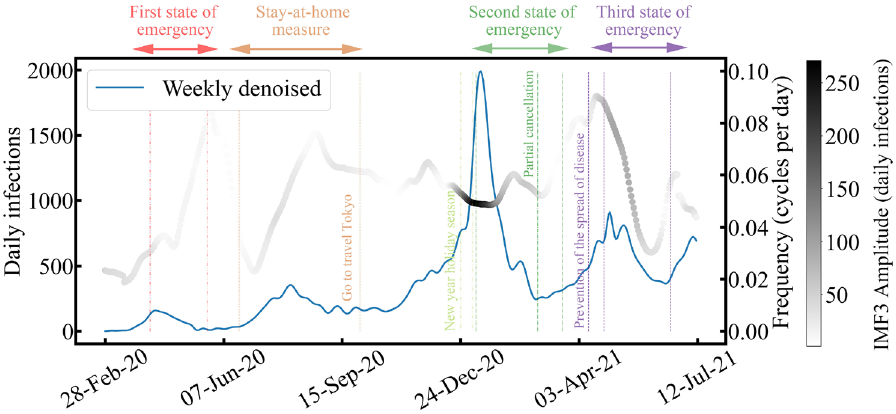
Figure 7. Comparison between the weekly denoised trend and the decomposed IMF 3 Hilbert spectrum.